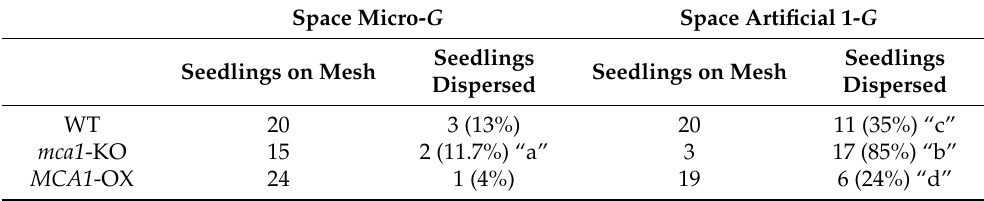
Table 1. Plants entangled with a mesh and those dispersed in the medium under different conditions. Letters in the table column denote significant differences between the groups; statistical significance was seen between “a” and “b”, “b” and “d” ( p < 0.01), and “c” and “b” ( p < 0.05) (the two-sample proportion test). Data of the MCA1 -OX and WT-MCA1-GFP lines were gathered and analyzed as MCA1 -overexpressing seedlings because both the MCA1 and MCA1-GFP genes were expressed from the same promoter, 35 S CaMV; the proportions of seedlings dispersed under micro- G (3/39, 7.7%) and 1- G (27/53, 50.9%) are statistically different ( p < 0.01). Under the micro- G condition, the percentage of mca1 -KO seedlings detached (11.7%) was nearly the same as that of the WT (13%) and MCA1 -OX seedlings (4%). There is no statistical difference. The proportion of the number of WT-MCA1-GFP seedlings dispersed under micro- G was (2/14, 14%) and 1- G was (21/28, 75%). These data show the same tendency as for the other seedlings. WT-MCA1-GFP seedlings are not included in the Table 1, since a certain fraction of WT-MCA1-GFP seedlings were fixed with paraformaldehyde (PFA). On the other hand, WT, mca1 -KO, and MCA1 -OX seedlings were treated with RNA-stabilizer. Space Micro- G Space Artificial 1- G Seedlings Seedlings Seedlings on Mesh Seedlings on Mesh Dispersed Dispersed WT 20 3 (13%) 20 11 (35%) “c” mca1 -KO 15 2 (11.7%) “a” 3 17 (85%) “b” MCA1 -OX 24 1 (4%) 19 6 (24%)